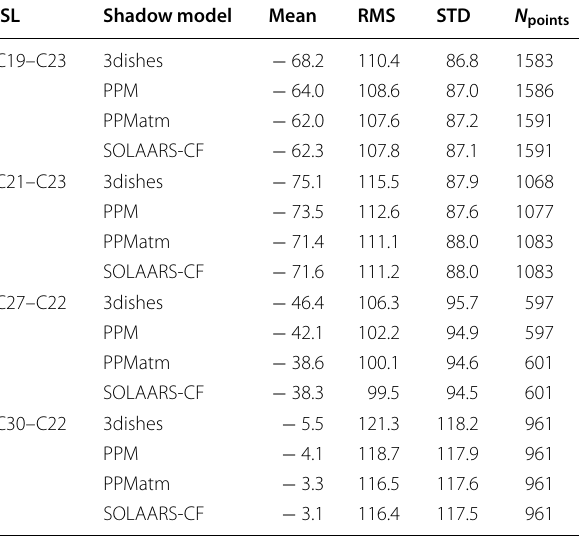
Table 7 Performance of different shadow models by ISL